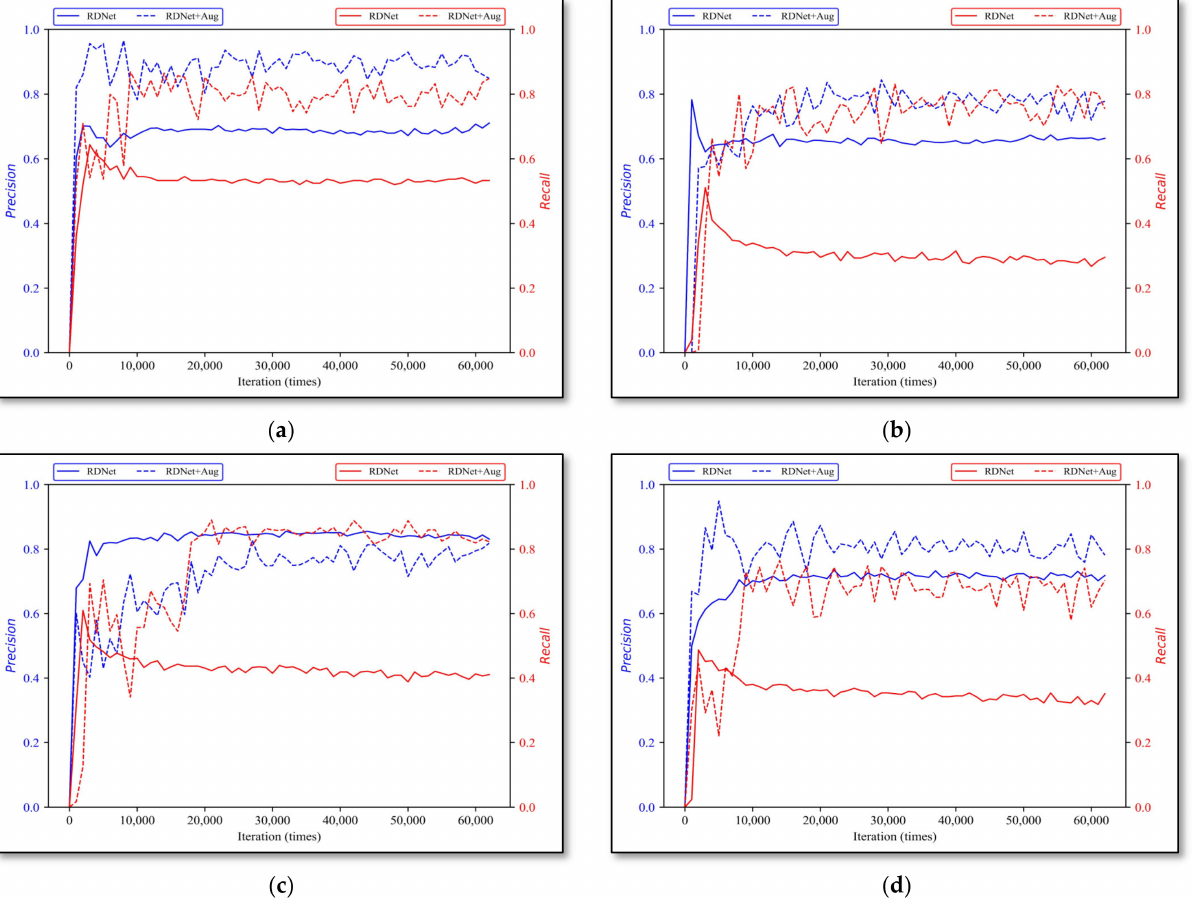
Figure 13. RDNet and RDNet + Aug evaluation results. ( a ) monzogranite, ( b ) sandstone, ( c ) shale, and ( d )